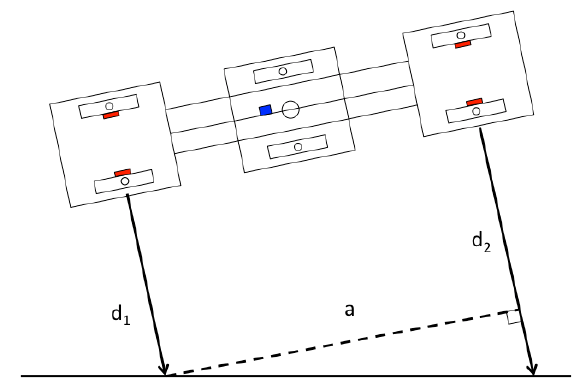
Figure 8. Straight alignment of the modules to estimate the orientation angle, which can be corrected by knowing the value of β j